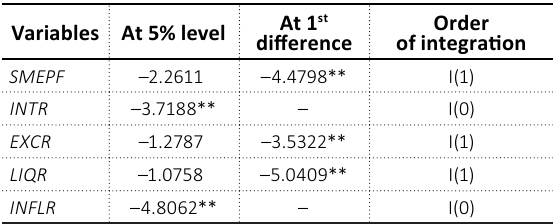
Table 2. Augmented Dickey-Fuller (ADF) unit